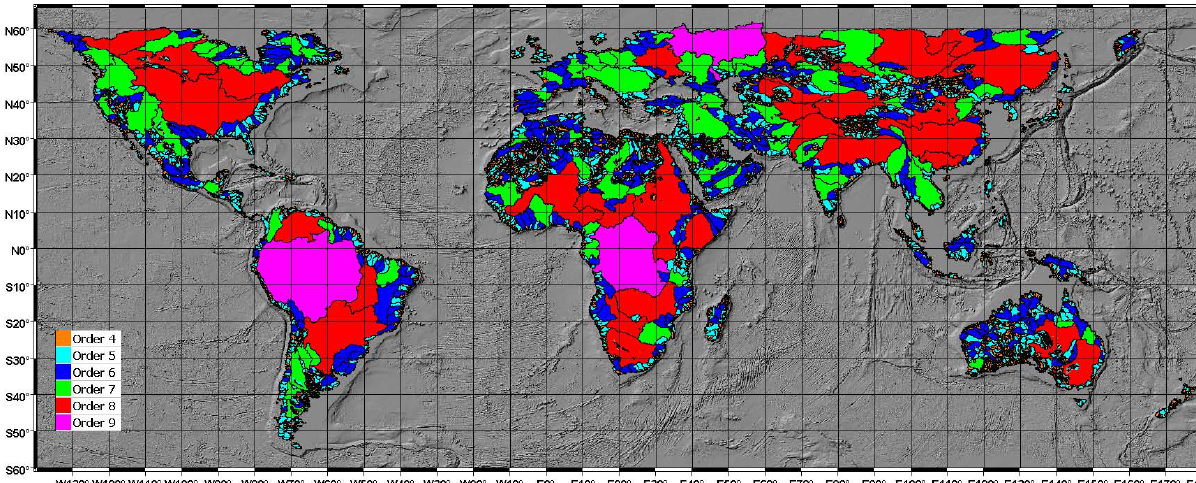
Fig. 3. Strahler order for the largest segment in global drainage